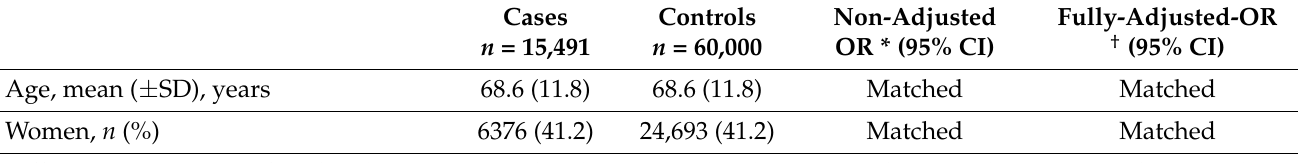
Table 1. Baseline characteristics of cases and